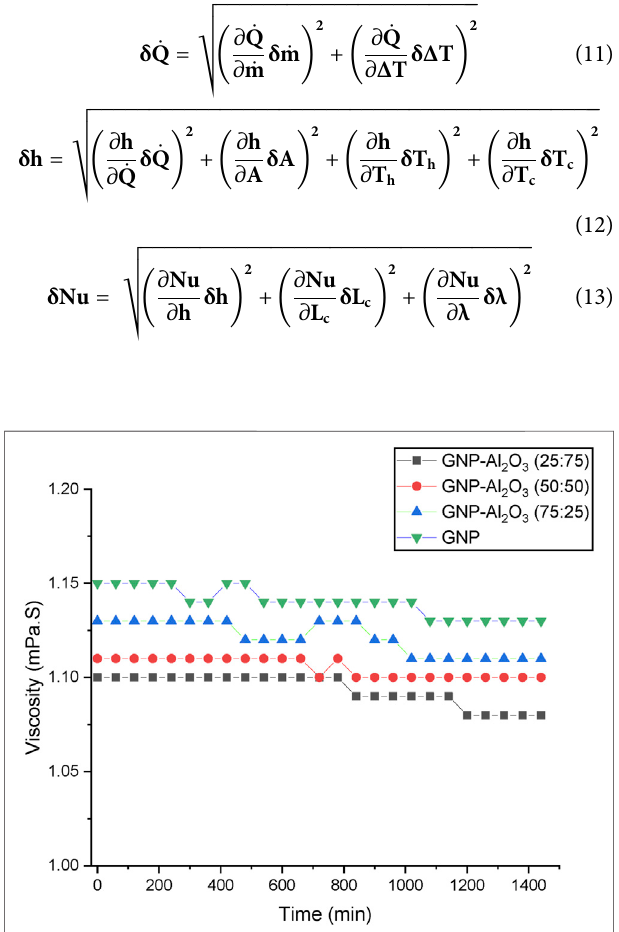
FIGURE3| Stabilityofthenano fl uidsusingtheviscositymeasurements.